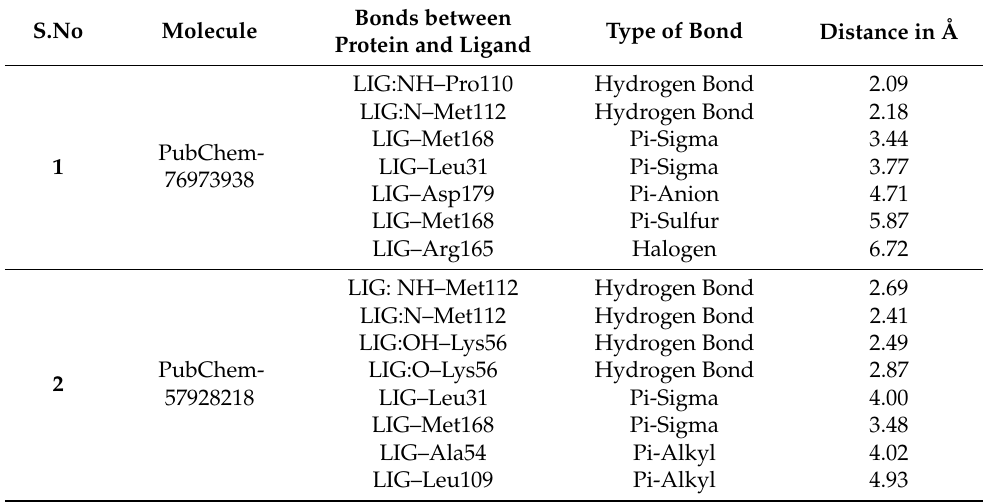
Figure 2. Selected four molecules whose docking presented high binding affinity towards AXL kinase. ( A ) Docking of PubChem-76973938 molecule into the active site of the AXL kinase. ( B ) PubChem-76973938 molecule interactions with AXL kinase. ( C ) Docking of PubChem-57928218 molecule into the active site of the AXL kinase. ( D ) PubChem-57928218 molecule interactions with AXL kinase. Table 2. Molecular docking of four selected molecules in the active site of the AXL kinase and their interactions with the AXL kinase amino acid